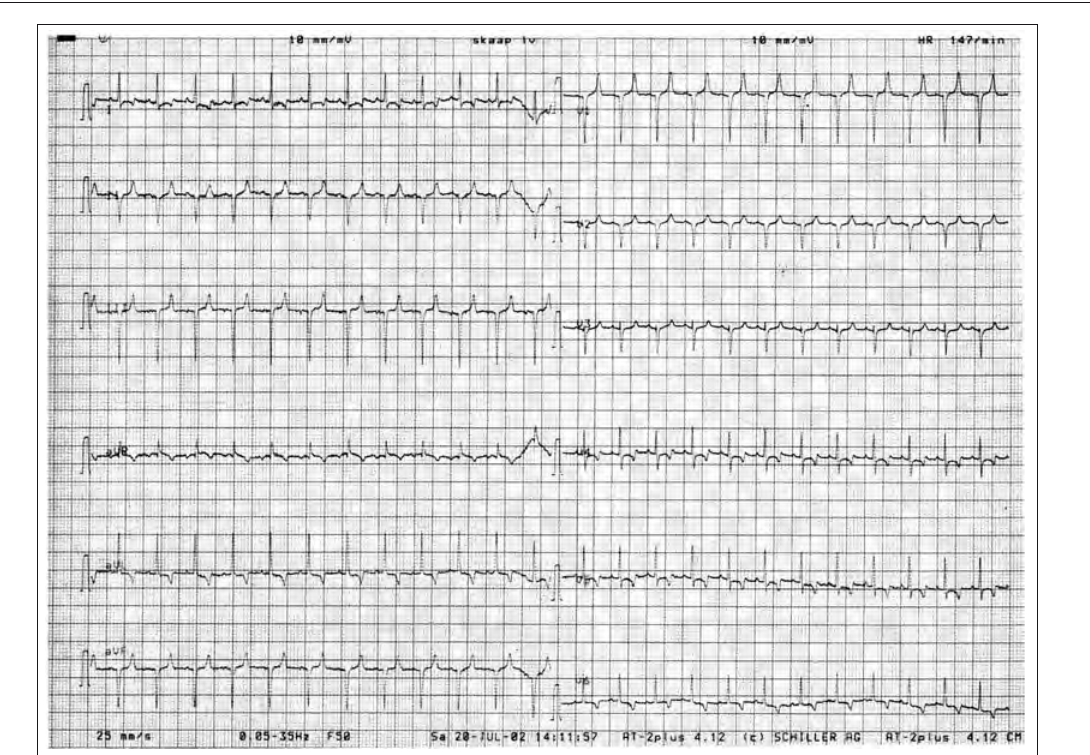
FIG. 4 This is the exact same 12-lead electrocardiogram after 28 min of PVCs. Note the increased amplitude in Lead V1 and the change in polarity of the QRS complex in Lead